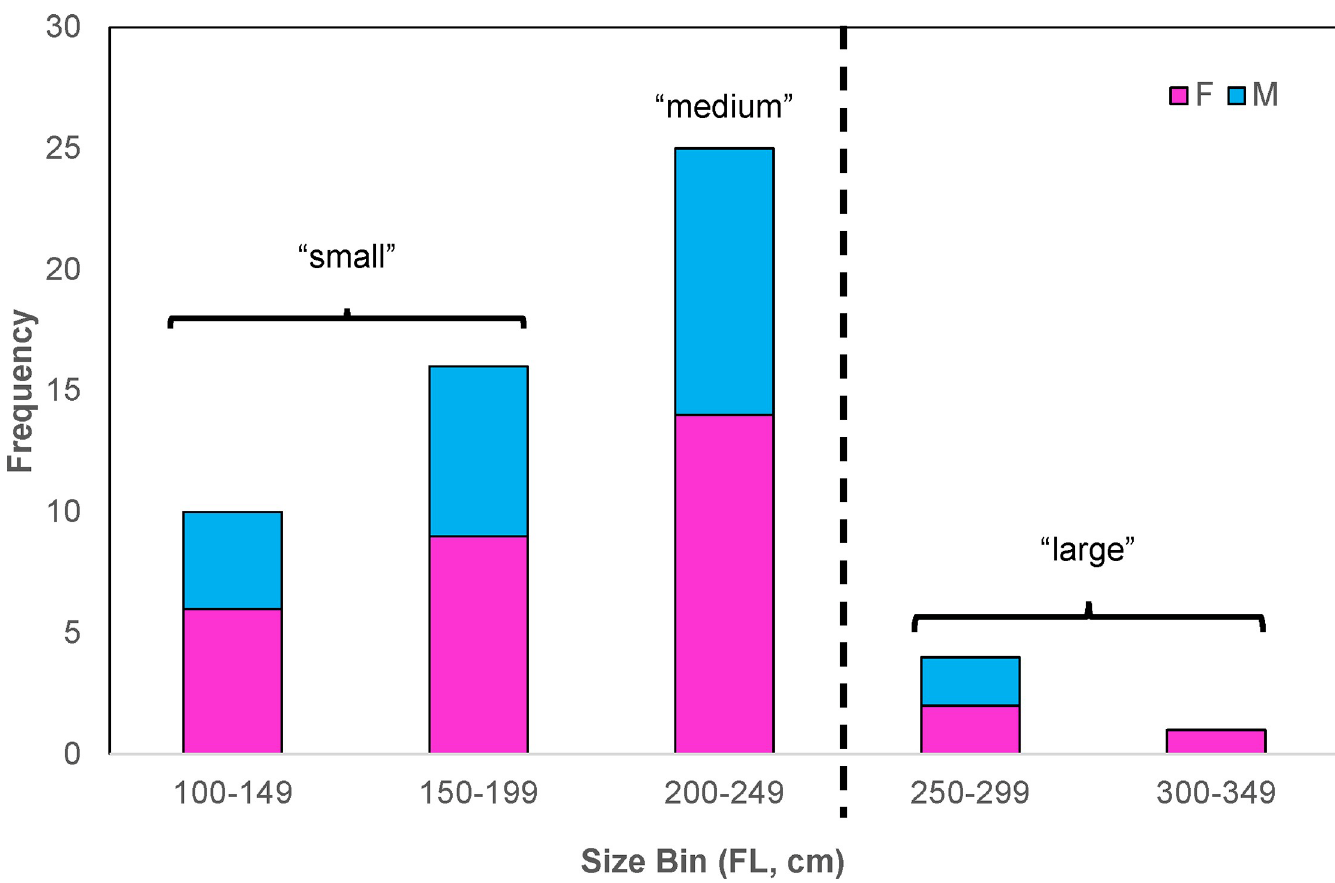
Fig 1. Frequency histogram of tiger shark sizes (fork length, FL) tagged in this study. Data are presented in 50 cm size bins. Sexes are represented by color (blue = male, pink = female). Vertical dotted line represents size-at-maturity break.